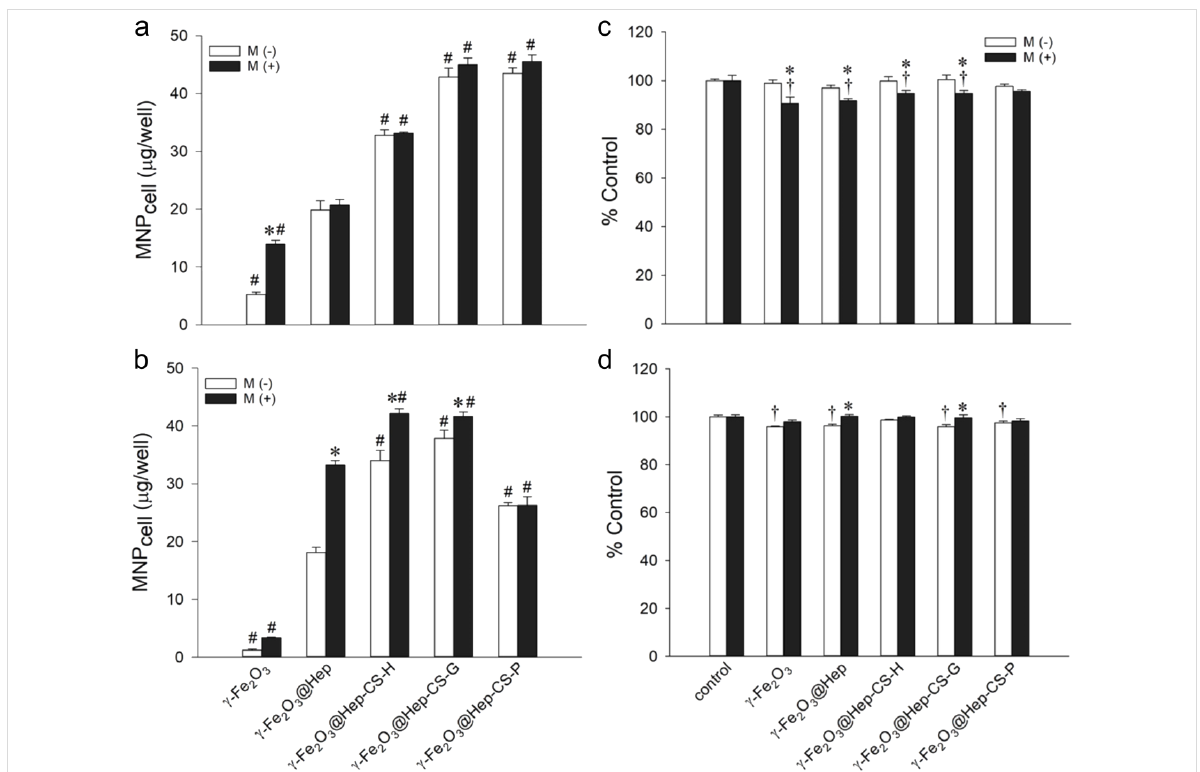
Figure 5: Cellular uptake of the phenolic compound-modified particles by (a) L-929 and (b) LN-229 cells. A magnetic field was applied for 5 min, M ( − ), or 3 h, M (+), after administration of the particles (100 μ g/mL). Values are shown as the mean ± standard error (SE; n = 3). * , # p < 0.05 compared to the corresponding M ( − ) and γ -Fe 2 O 3 @Hep species, respectively. Cell viability of the phenolic compound-modified particles in (c) L-929 and (d) LN-229 cells. A magnetic field was applied for 5 min, M ( − ) or 3 h, (M +), after administration of the particles (100 μ g/mL). The control measure- ment was performed in the absence of the particles. Values are shown as the mean ± SE ( n = 3). * ,† p < 0.05 compared to the corresponding M ( − ) and control groups,